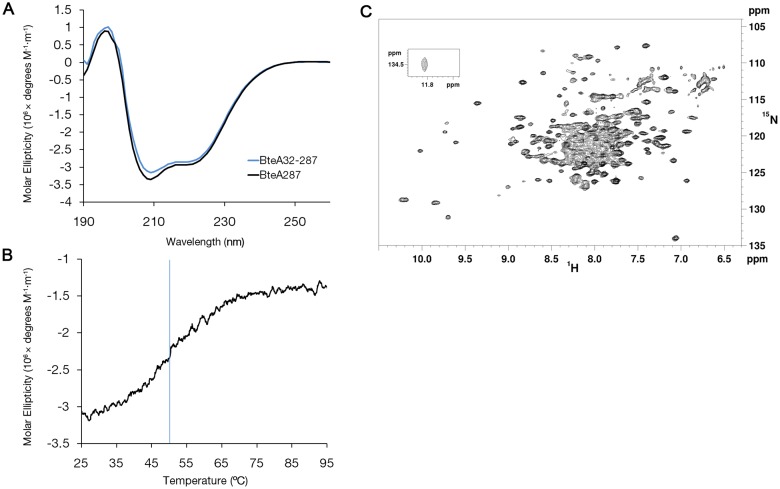
Circular dichroism analysis of BteA287 and 2D 1H,15N-TROSY-HSQC spectrum of BteA287.(A) Dichroic spectra for BteA287 (black line) and BteA32-287 (blue line). (B) Melting curve of BteA287, measured at 222 nm (blue line indicates calculated Tm). (C) Spectrum was acquired for a triply-labeled [2H,13C,15N]-BteA287 0.4 mM sample in 100 mM NaCl, 20 mM NaPi pH 7.3 at 303 K and 16.4 T. The inset shows an outlying indole NH peak.